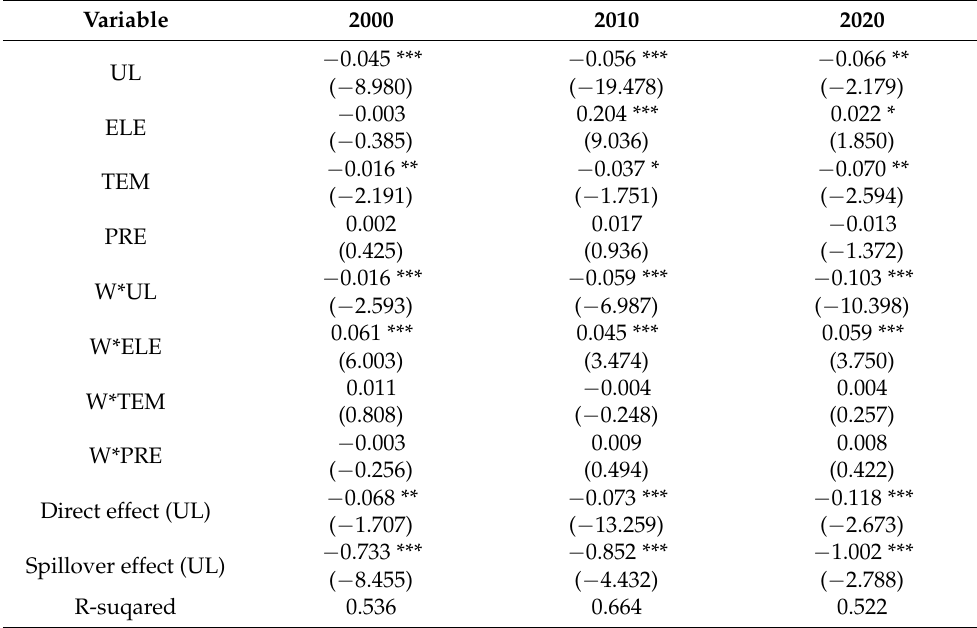
Table 3. Estimation results of spatial Durbin model.